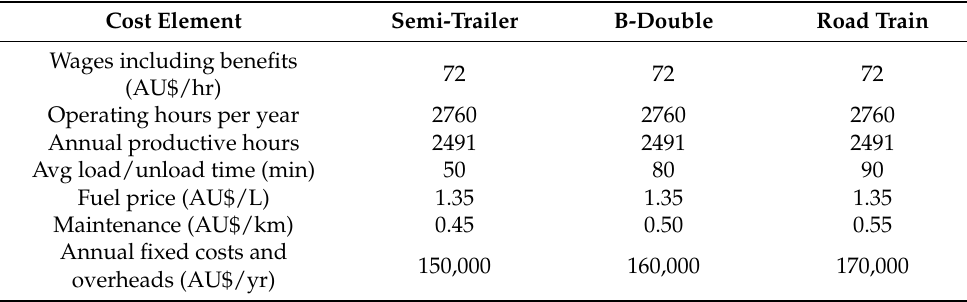
Table 2. Typical Australian indicative industrial transport costing parameters.